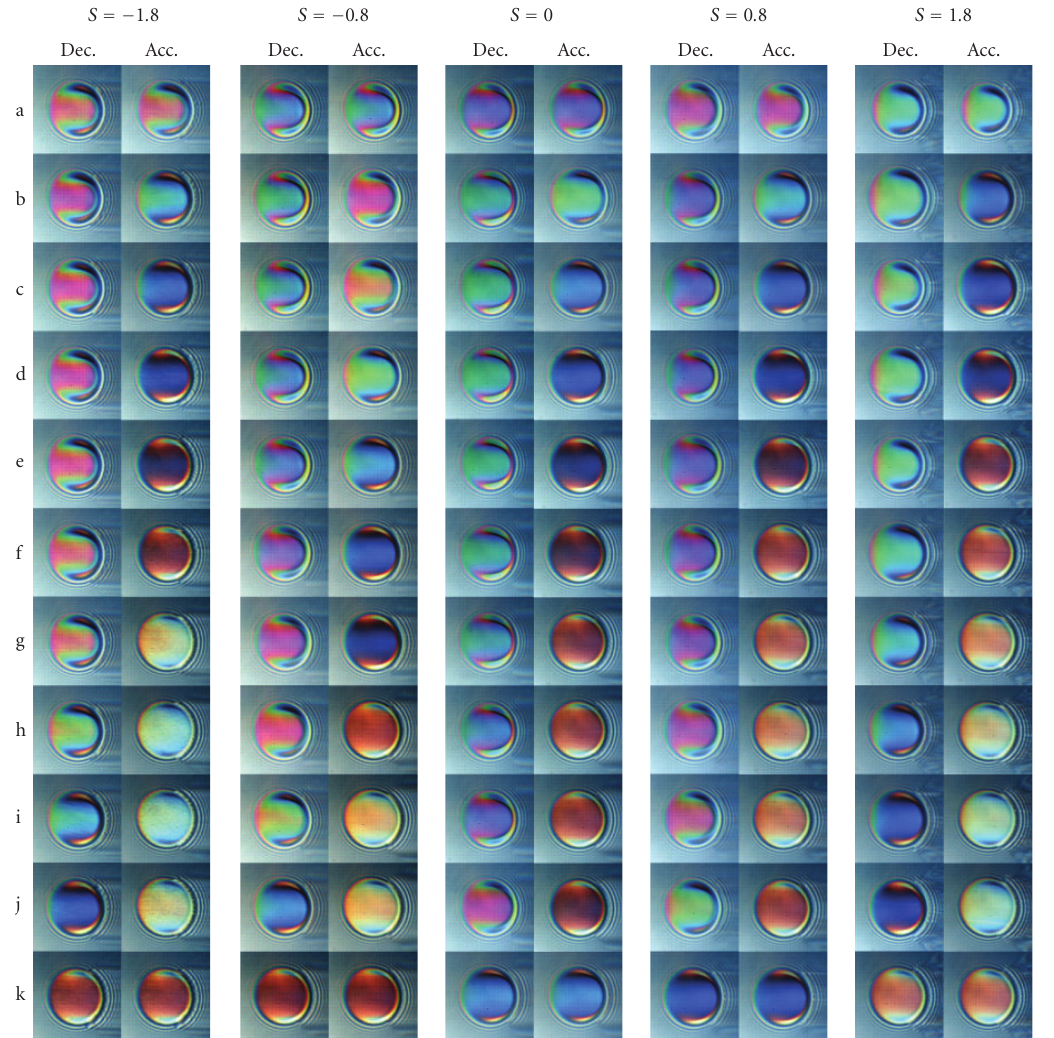
Figure 17. The gross lines refer to the central film thicknesses and the thin lines refer to the minimum film thicknesses, while the solid lines refer to the film thicknesses obtained at test frequency of 1 Hz and the dashed lines refer to the test frequency of 0.25 Hz. The arrows show the direction